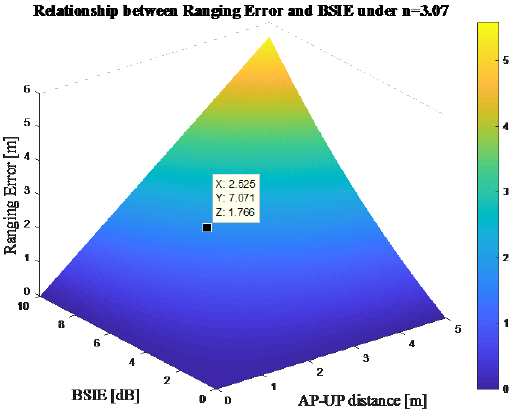
Figure 2. Relationship between ranging error and Body-Shadowing Influence Error (BSIE). UP: unknown point.